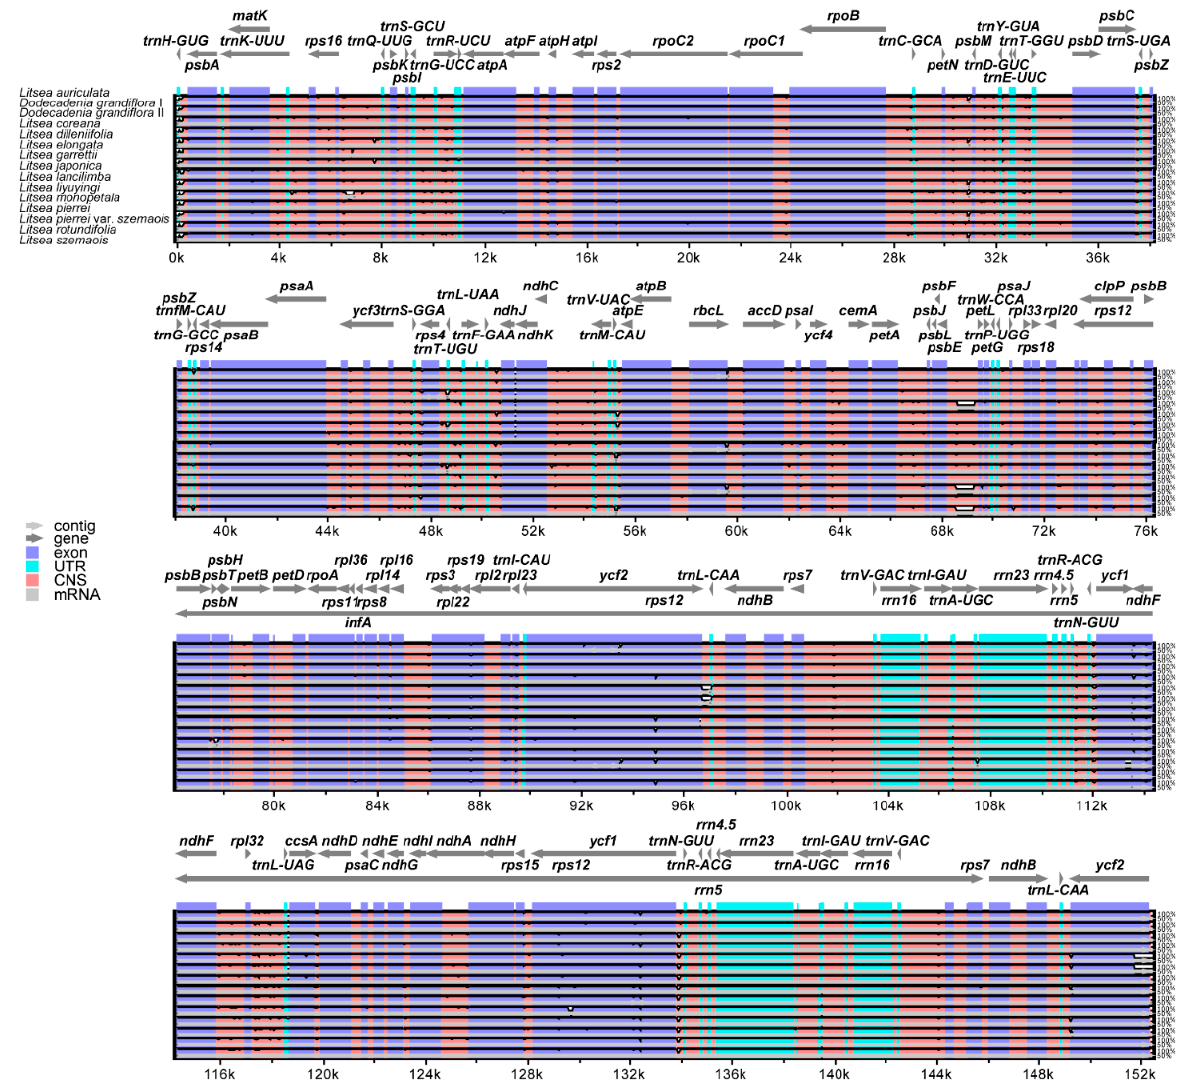
Figure 7. Visualization of D. grandiflora and 13 Litsea plastomes with Litsea auriculata as reference.